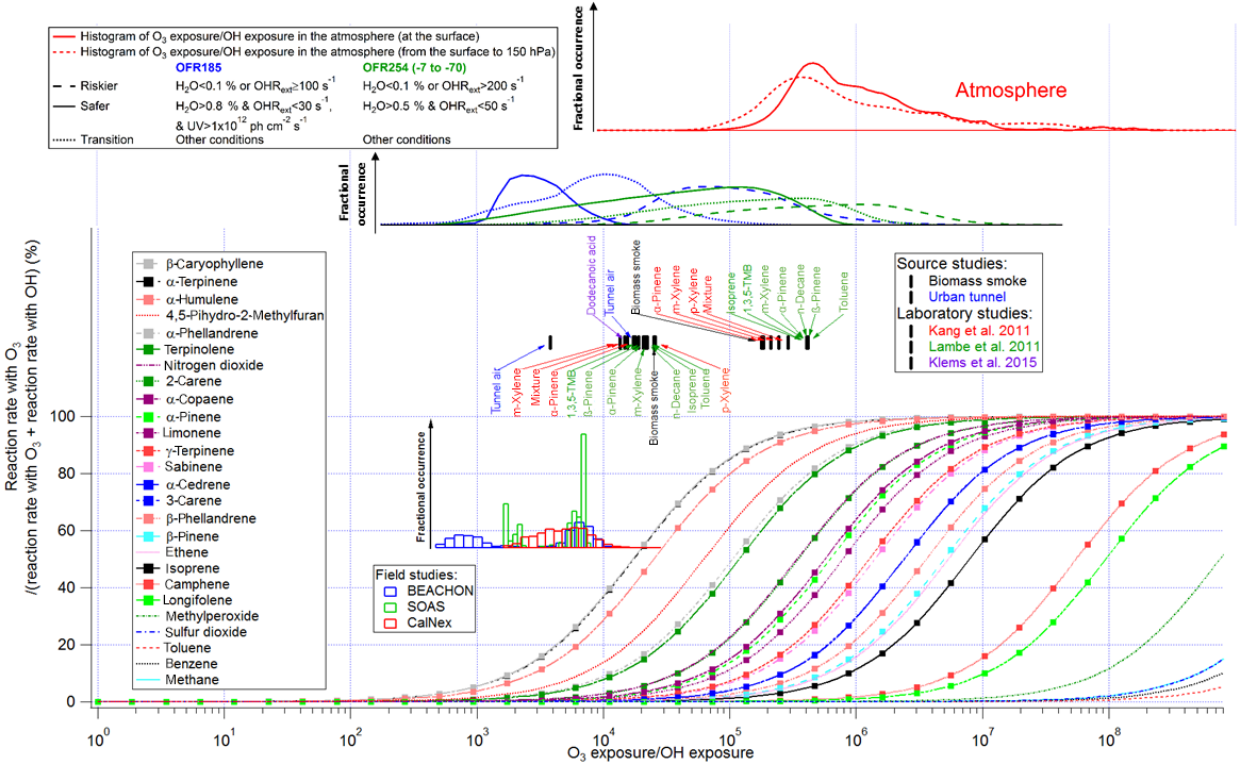
Figure 5. Same format as Fig. 2 but for the fractional importance of the reaction rate with O 3 vs. OH as a function of the relative exposure of O 3 and OH. The curves of biogenics are highlighted by squares. Also shown are modeled distributions of the relative exposure of O 3 and OH at the Earth’s surface (solid line) and throughout the column from the surface to a height with a pressure of 150hPa (dashed line). The distributions were calculated from the mean daily concentrations of O 3 and OH as simulated by the GISS